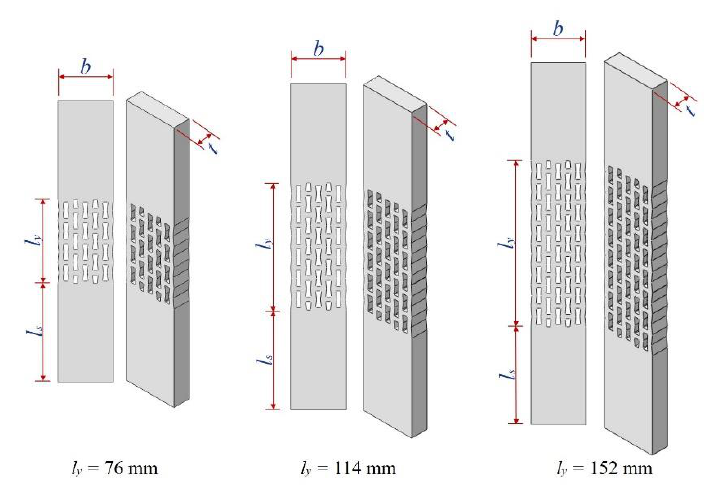
Figure 25. H40A85R0.5 specimens with different lengths of perforated area.